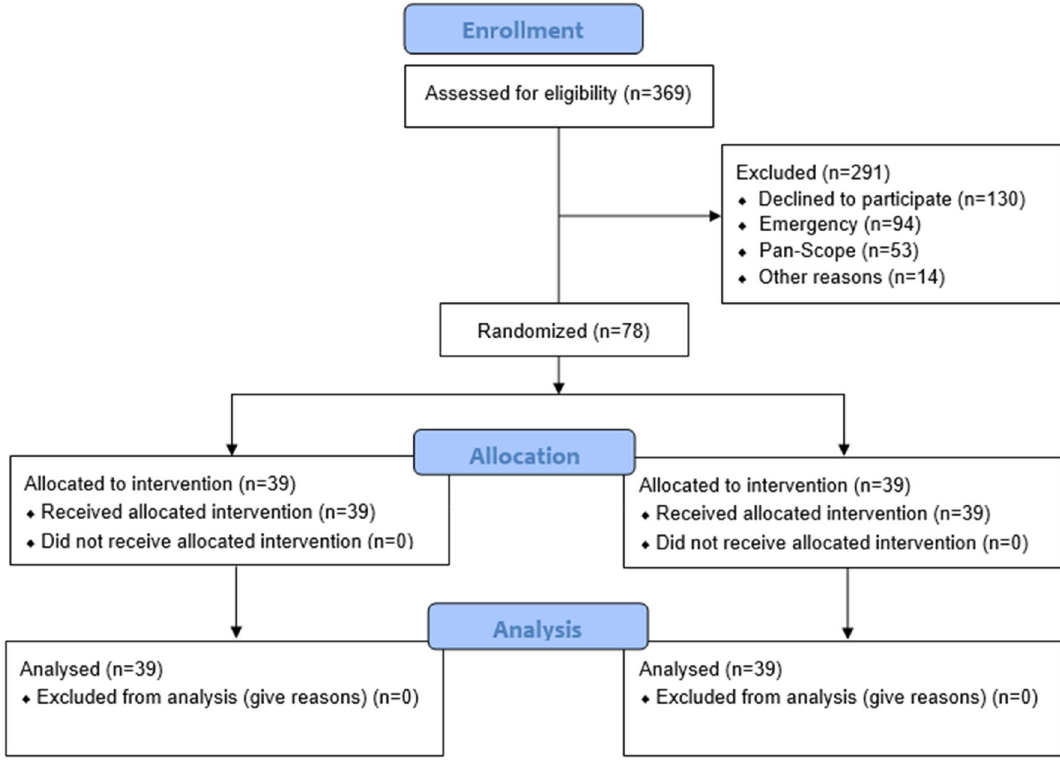
Figure 2. CONSORT flow of the